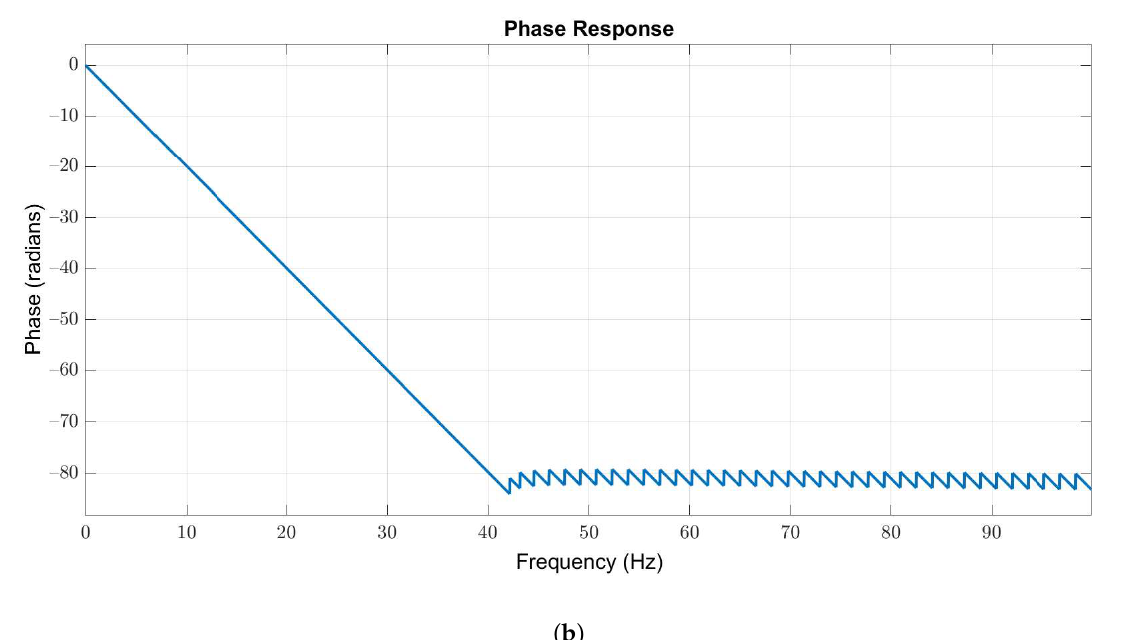
Figure 3. ( a ) Magnitude and ( b ) phase responses of the low-pass filter with passband and stopband edges at 40 Hz and 42 Hz, respectively.